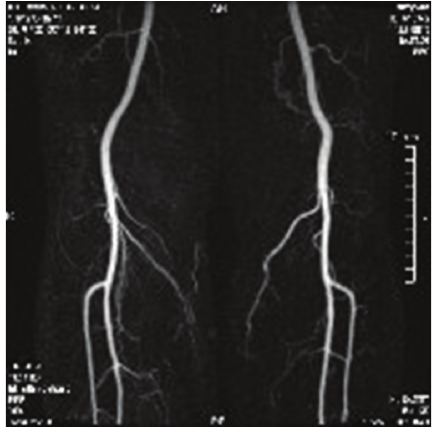
Figure 2: Magnetic resonance arteriography shows the absence of PTA in both limbs through the hypertrophic collateral flow, which takes place in the inferior genicular